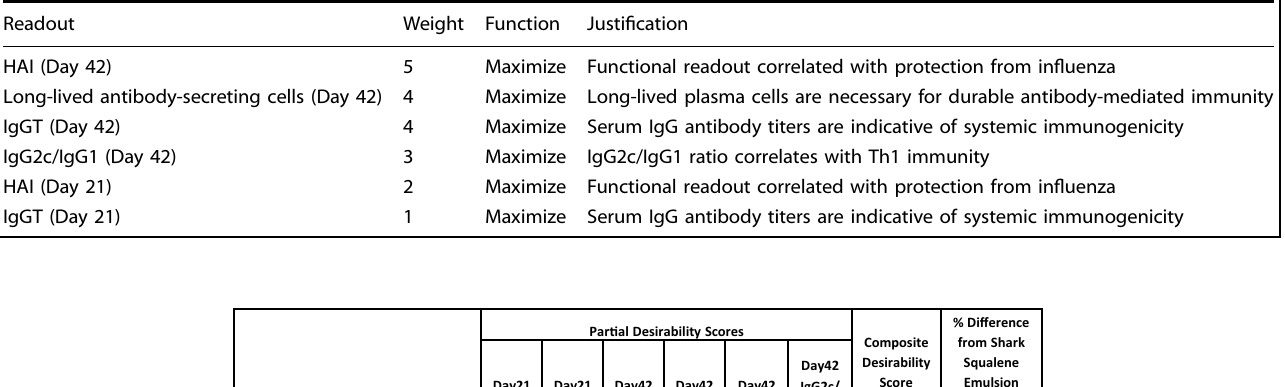
Table 3. Desirability function weighting scheme.